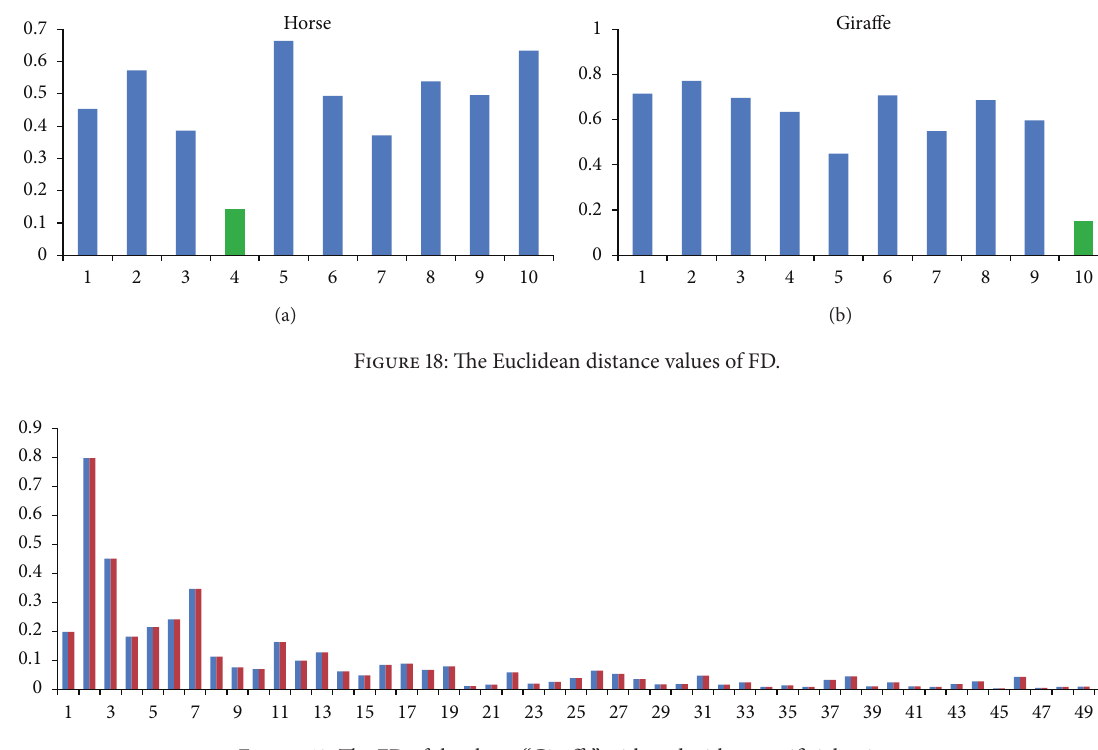
Figure 19: The FD of the shape “Giraffe” with and without artificial